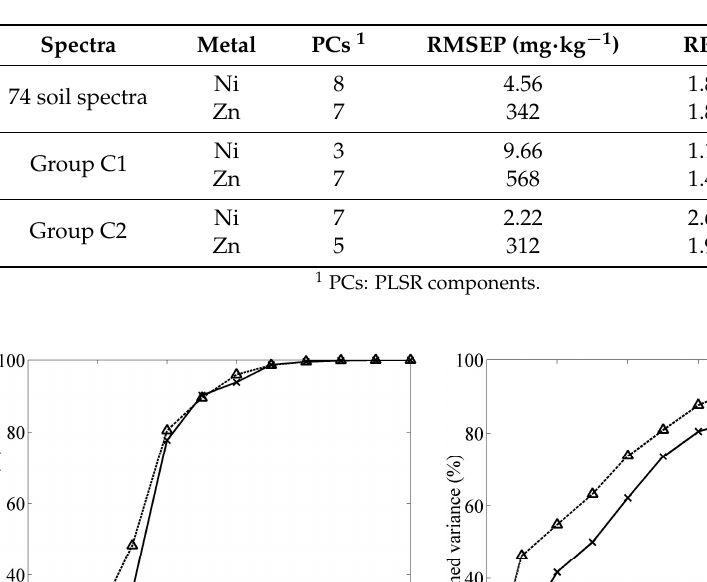
Table 3. Prediction accuracies based on Cosine of spectral angle.